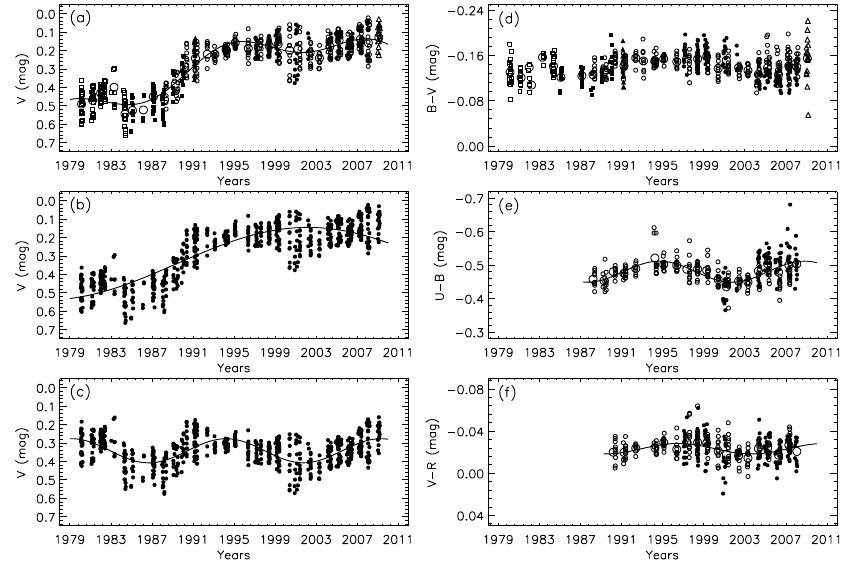
Fig. 2. The light and color curves of DM UMa. The symbols shown as filled and empty circles, filled and empty squares, filled and empty triangles denote the observations taken from the Ege University Observatory and Rosario et al. (2009), Mohin & Raveendran (1992) and Mohin et al. (1985), Mohin & Raveendran (1994) and Rosario et al. (2011), respectively. The yearly mean brightnesses and colors are also shown by larger empty circles. The fits derived from period analysis are indicated by solid lines. All V data used in this study and their representation derived with a combination of two periods are shown in panel (a). Panel (b) represents the same data fitted with the main period. Panel (c) gives the residuals from (b) fitted with the secondary period. In panels (b) and (c) the filled circles for all data are just used to remove complexity. The